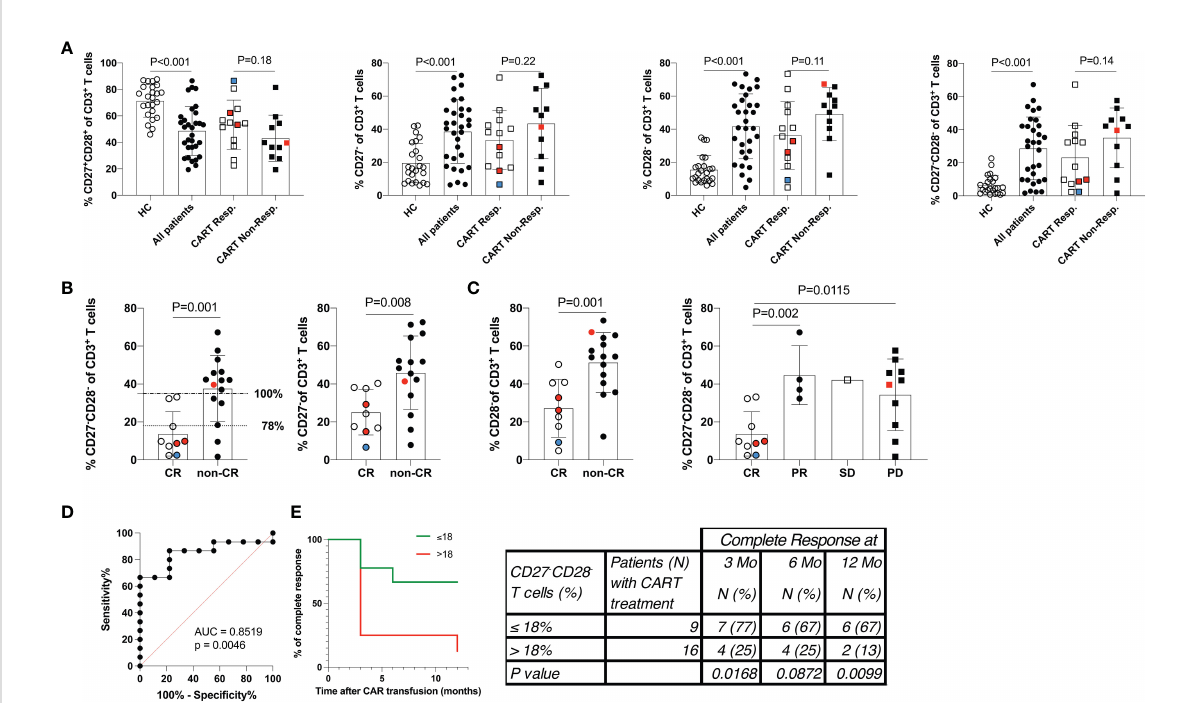
FIGURE 2 Low frequency of differentiated CD3 + CD27 - CD28 - T cells predicts a favorable response to CART cell therapy. (A) The distribution of PB CD3 + T cell populations strati fi ed by the CD27 and CD28 expression status is given. Data show 24 healthy control subjects (HC), 31 of 33* r/r DLBCL patients scheduled for CART cell therapy, and more detailed data for 13 of 15* CART cell responders and all non-responders (n=11). (B) Shows the distribution of PB CD3 + T cell populations strati fi ed by the CD27 and CD28 expression status in patients who were further separated into 9 of 11* complete responders and compared to 15 non-complete responders. Horizontal lines at 18% of CD3 + CD27 - CD28 - T cells indicate the 78% (dotted line) and at 35% of CD3 + CD27 - CD28 - T cells indicate 100% (dashed-and-dotted line) speci fi city levels (at sensitivity levels of 87% and 67%, respectively) of numbers of CD3 + CD27 - CD28 - T cell numbers to predict CR (C) Shown are the numbers of CD3 + CD27 - CD28 - T cells of patients who achieved complete remission (CR), partial remission (PR), stable disease (SD) or progressive disease (PD). P-values (unpaired Student ’ s t-test) are indicated. Cell frequencies were determined in 31 of 33* patients. Patients were treated with tisagenlecleucel (white/black symbols), axicabtagene ciloleucel (red symbols) or YTB323 (blue symbols). *) PB of two patients belonging to the CART responders was not available for analyses at this stage. (D) ROC (receiver operator characteristics) curve indicating the performance of numbers CD3 + CD27 - CD28 - T cells for classifying CR. (E) Duration of complete remission (CR) after CART cell therapy. Shown are the percent of patients presenting with CR over the observational period of 12 months (Mo) with staging at 0, 3, 6 and 12 months. Patients were strati fi ed according to those with >18% or ≤ 18% of CD3 + CD27 - CD28 - T cells at the time of leukapheresis. Table shows the number (N) of patients within each group at each time point (percent of group in parenthesis). P values were calculated with Fisher ’ s exact